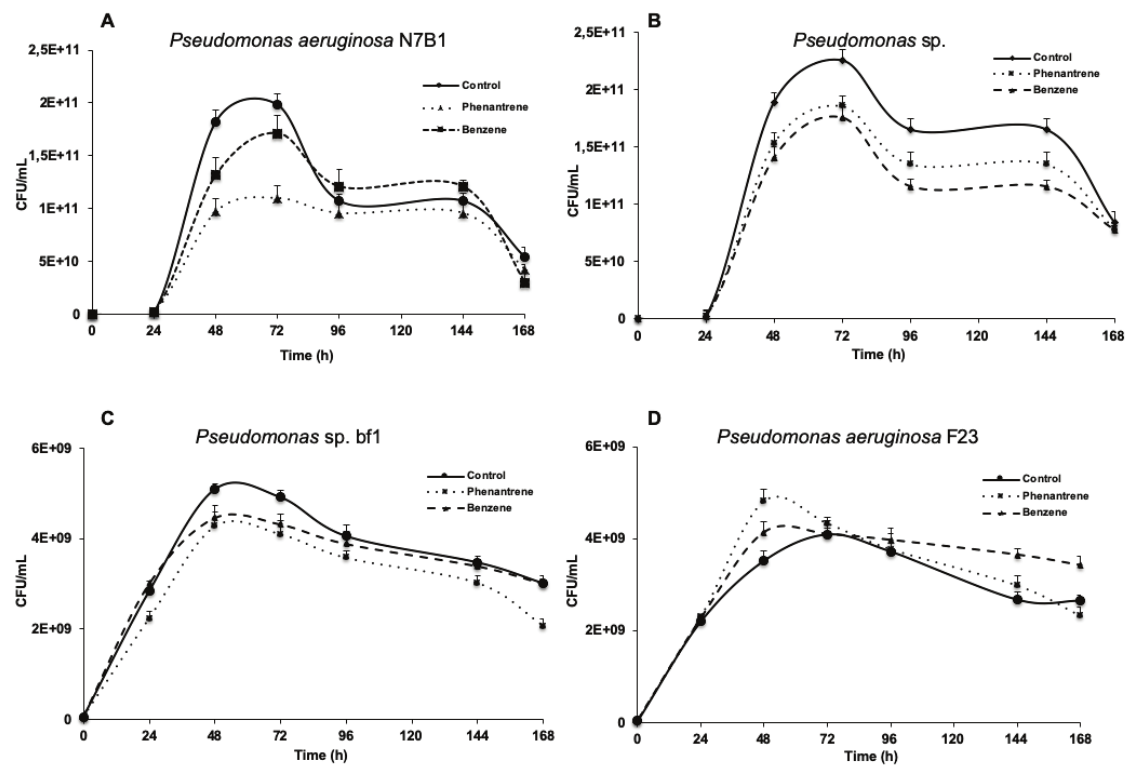
Figure 1: Microbial growth curves of Pseudomonas strains in BHB medium with phenanthrene 500 ppm and benzene 1000 ppm A) Pseu- domonas aeruginosa N7B1, B) Pseudomonas sp. C) Pseudomonas sp bf1, and D) Pseudomonas aeruginosa